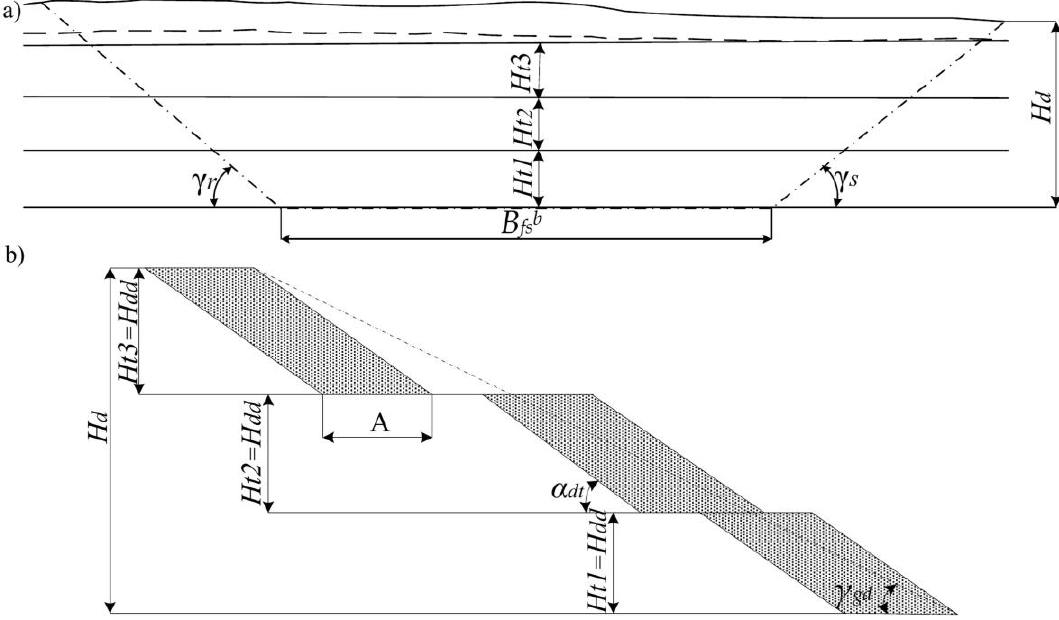
Figure 7. Schemes of the internal dragline-made dump: a - front view, b - cross section.